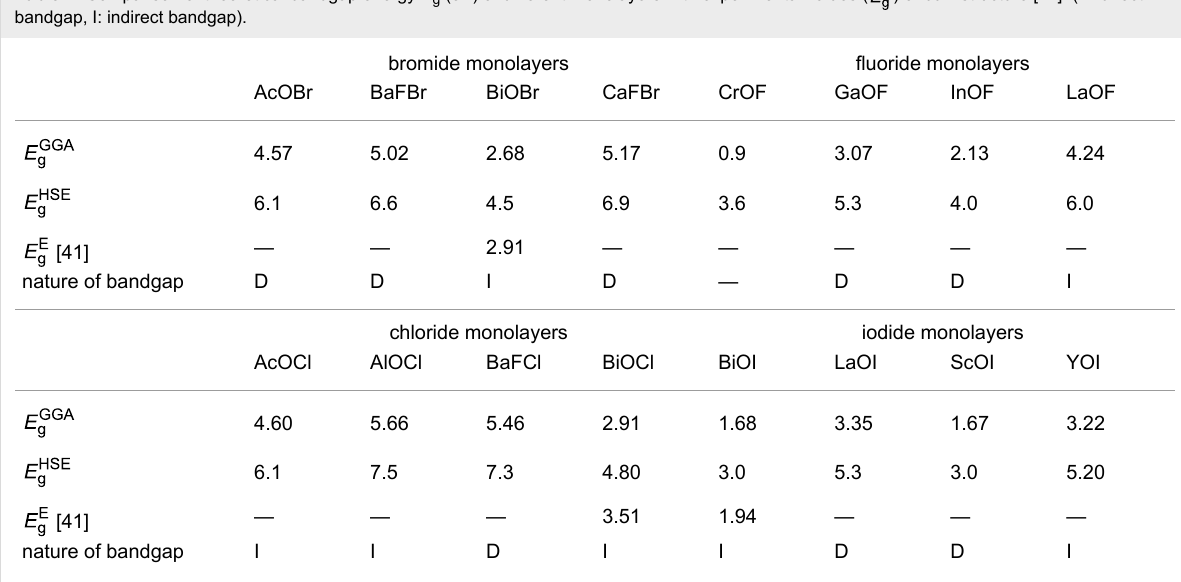
Figure 10: Band structures of the monolayers : BiOI, LaOI, ScOI, and YOI, using HSE functional. The Fermi level is set to 0 eV.